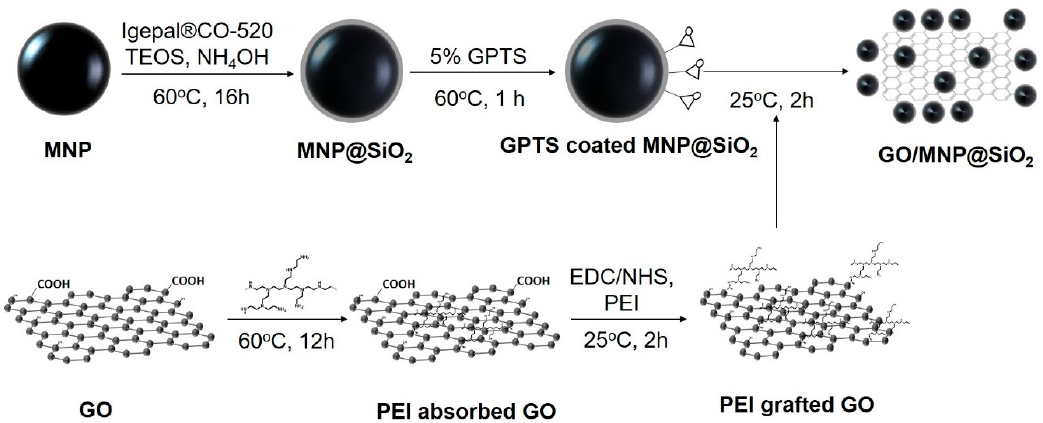
Figure 1. Schematic of the preparation of silica-coated superparamagnetic iron oxide nanoparticles grafted graphene oxide nanostructures (GO/MNP@SiO 2 ).